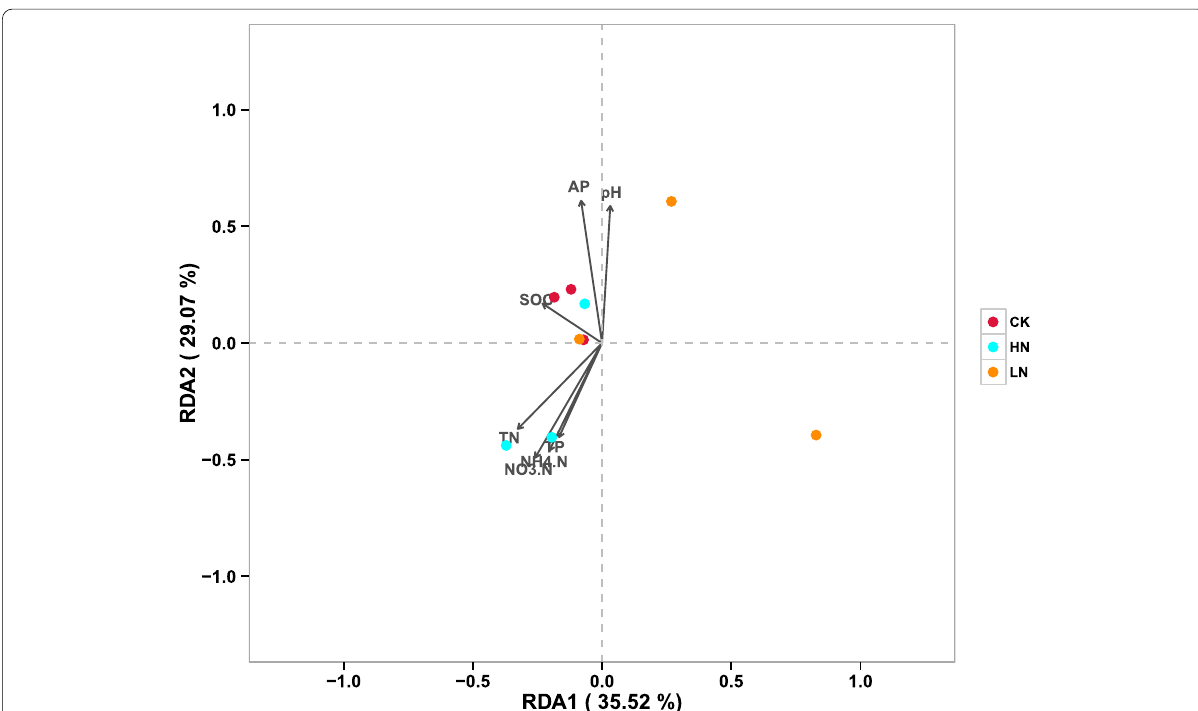
Fig. 6 Changes in the genus‑level composition of soil bacterial communities under different nitrogen deposition